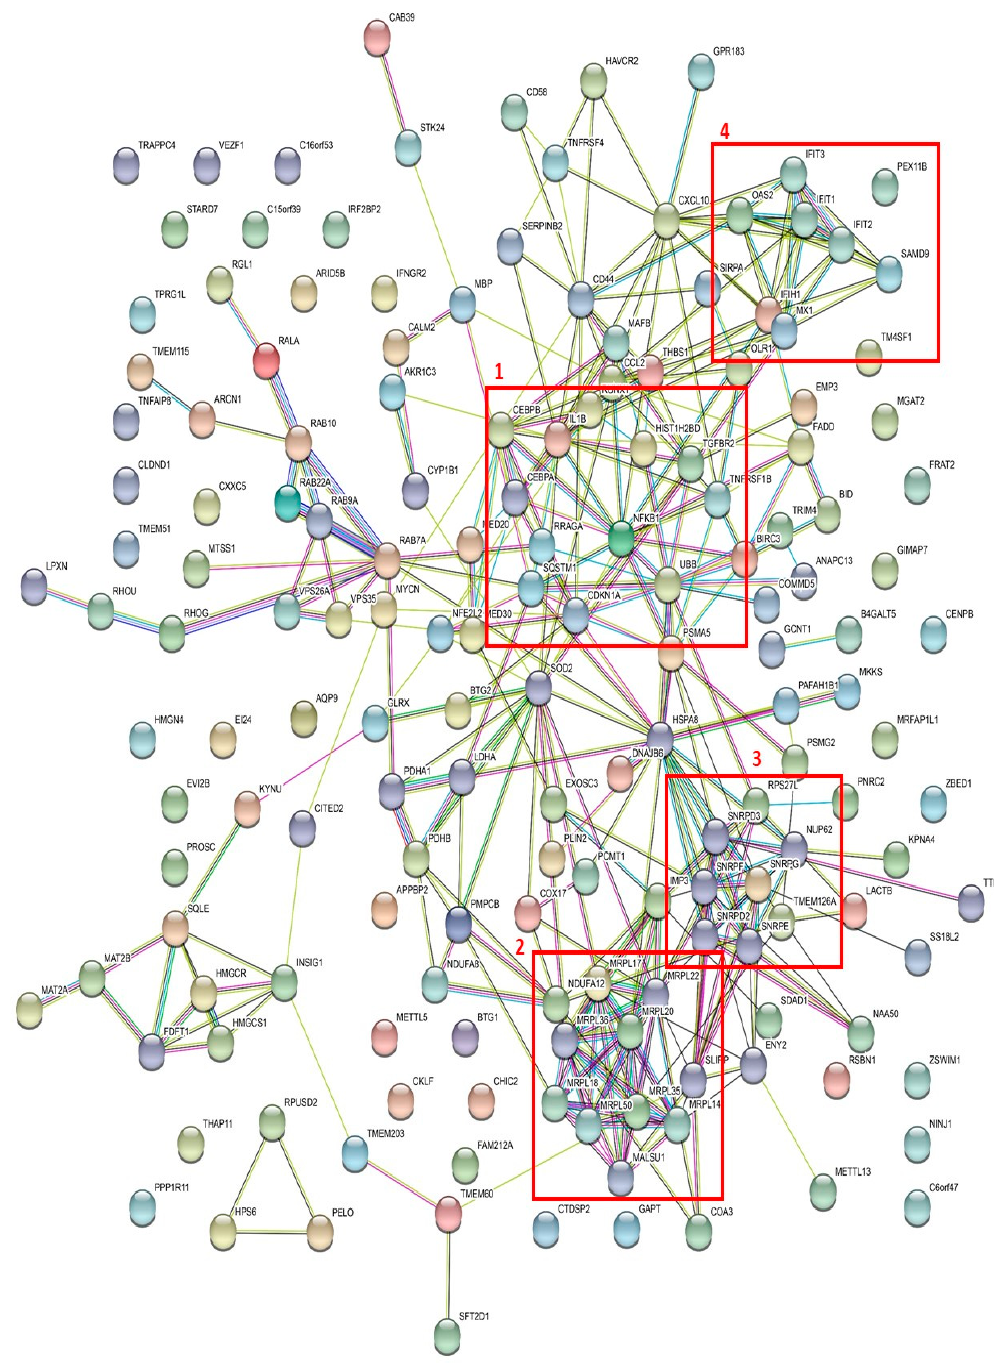
Figure 4. Network analysis of genes with downregulated expression after NF- κ B inhibition: The figure presents a network analysis based on the proteins encoded by the 183 genes that were downregulated by NF- κ B inhibition. By using the STRING database, we were able to identify a strong network where each individual node represents a single, protein-coding gene, and the number of connections indicates the number of specific and functionally relevant molecular interactions (i.e., functional interactions but not necessarily a direct binding between the molecules). Four extensive networks were identified by this analysis, as indicated in the Figure. 1, an nuclear factor- κ B 1 (NFKB1) network; 2, a network including several mitochondrial ribosomal protein large (MRPL) proteins; 3, a network including several small nuclear ribonucleoprotein polypeptides (SNRP) molecules; and 4, a network including many interferon-induced protein with tetratricopeptide repeats